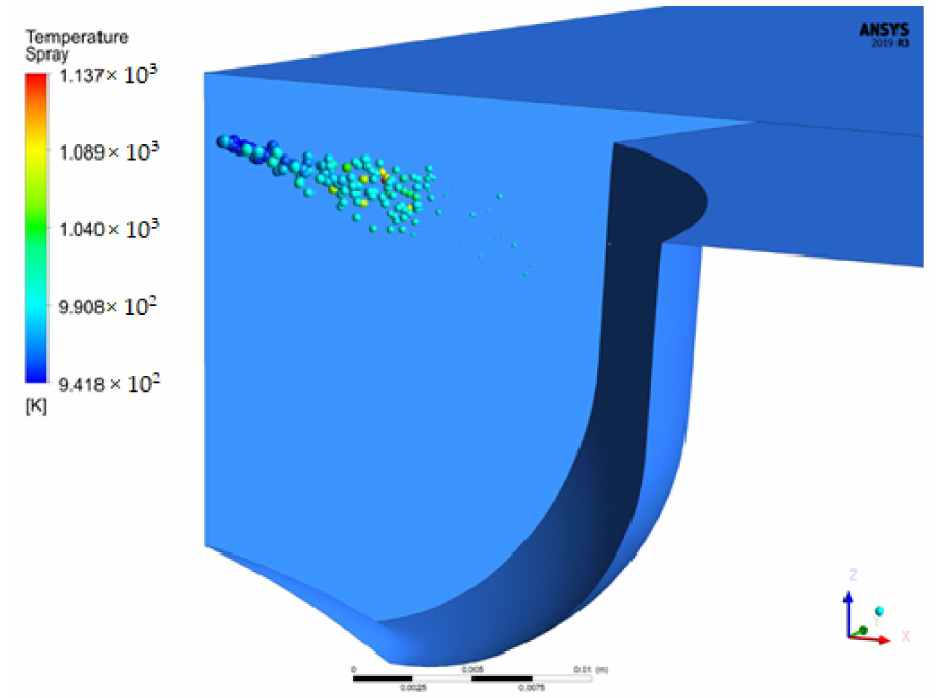
Figure 12. Spray of